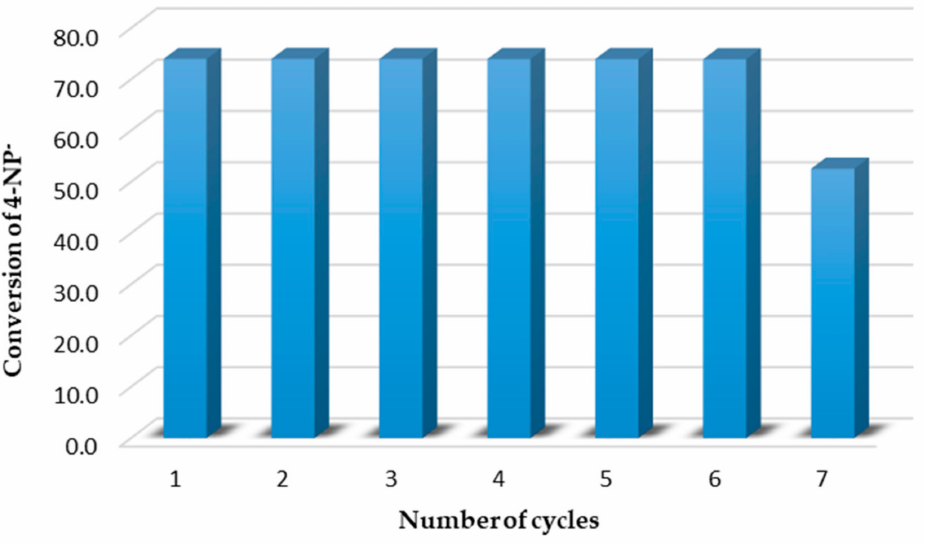
Figure 4. Recycling studies for the reduction of 4-NP to 4-AP, using Re/G as catalyst (0.2 µ mol of Re immobilized at the carbon support; T = 50 ◦ C; 15 W power; [4-NP] = 7.5 × 10 − 3 M; [NaBH 4 ] = 0.169